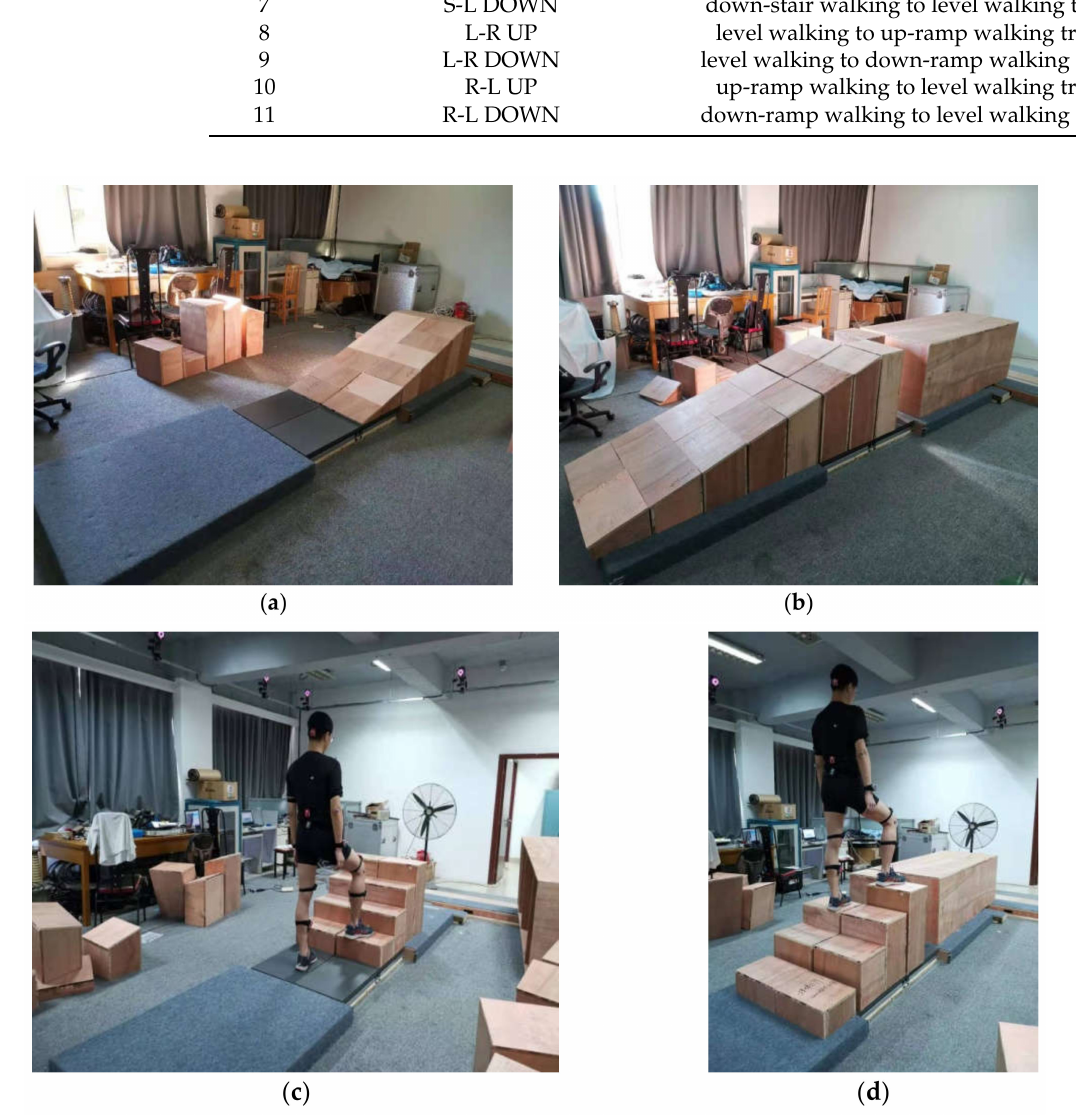
Figure 1. Experimental platform: ( a ) level walking to up-ramp walking and down-ramp walking to level walking; ( b ) up- ramp walking to level walking and level walking to down-ramp walking; ( c ) level walking to up-stair walking and down-stair walking to level walking; and ( d ) up-stair walking to level walking and level walking to down-stair